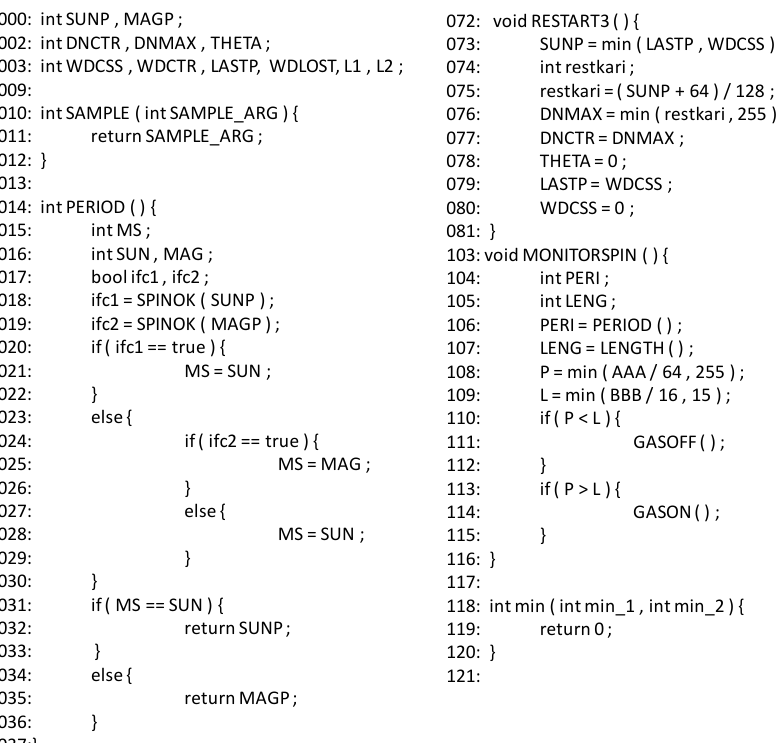
Figure 15. Outline of ECSW structure for spin stabilized satellite.